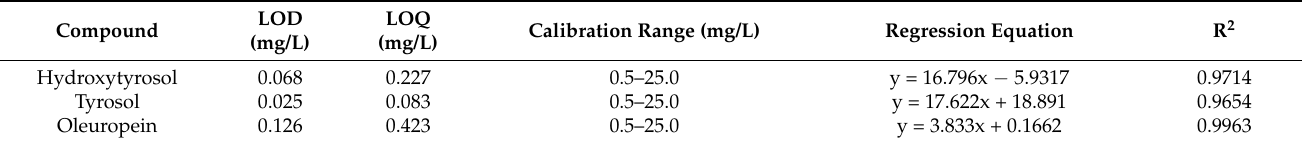
Table 1. Chromatographic characteristics of standards.